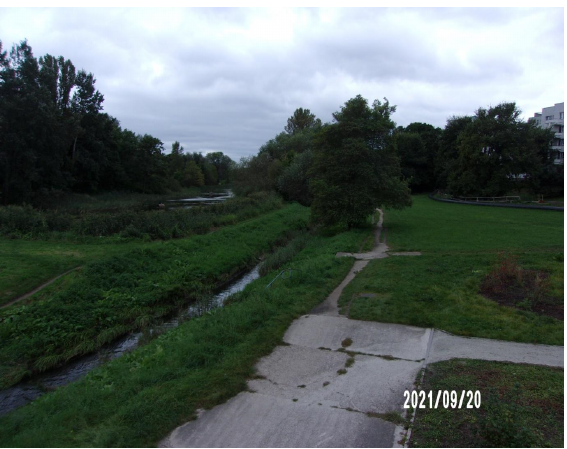
Figure A15. Wolica Canal draining rainwater from Ursyn ó w with an intensity of 8 m 3 s − 1 at the confluence with the S ł u ż ewiecki Stream (source: own).